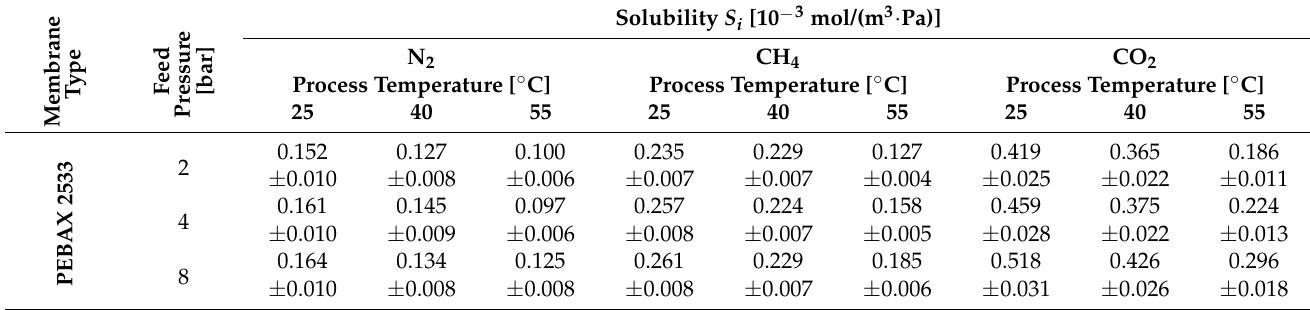
Table A9. Solubility coefficient of homogeneous membranes to different gases measured for different feed pressure and temperature values.